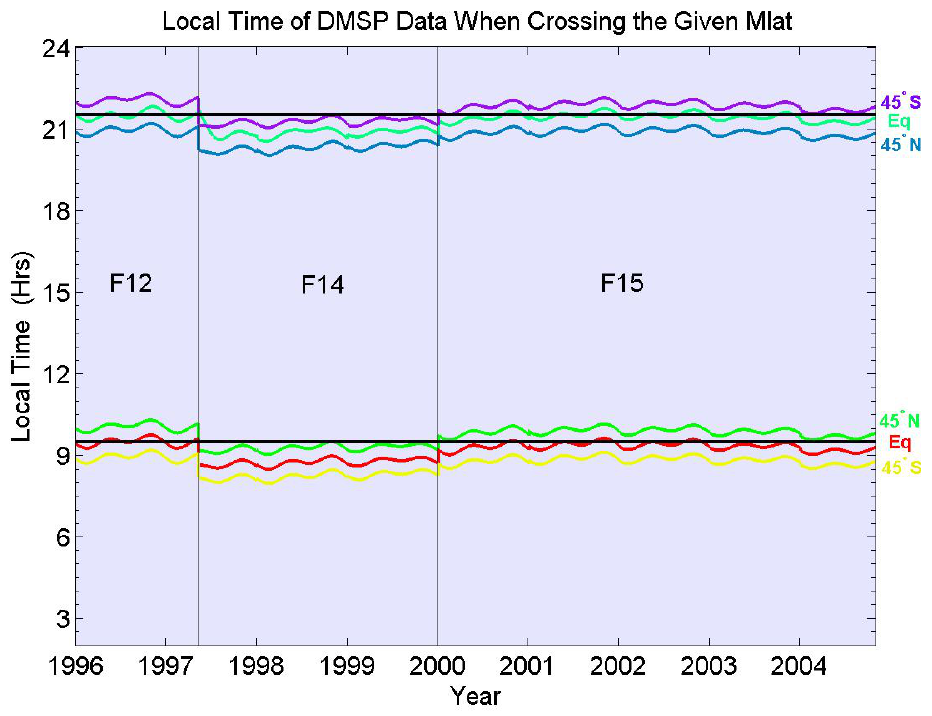
Fig. 1. Local time of DMSP satellites being used in the paper when crossing the given geomagnetic latitudes. Horizontal black lines denote Figure 1. Local time of DMSP satellites being used in the paper when crossing the 09:30 LT and 21:30 LT, given geomagnetic latitudes. Horizontal black lines denote 0930 LT and 2130 LT, respectively.